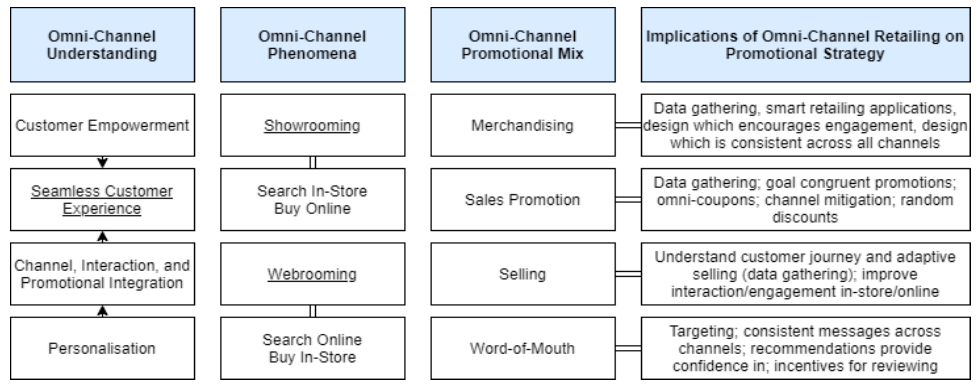
Figure 2. Overview of the discussed topics.